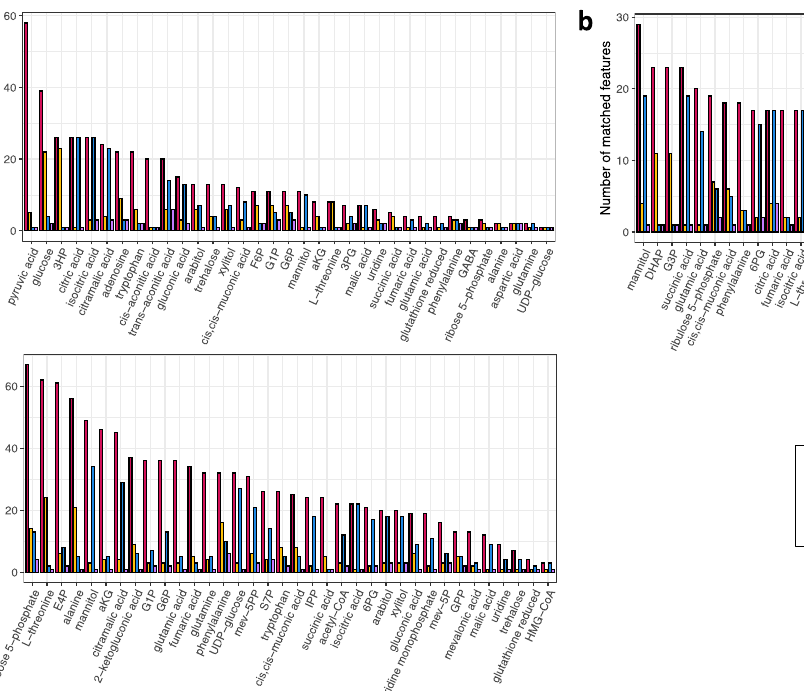
Fig. 4 | Annotation selectivity by different analytical separations in microbial samples. a A.pseudoterreus and A.niger ( n =46). b P.putida ( n =22). c R.toruloides ( n =48). Bars represent the number of possible LC-IM-MS peaks from untargeted feature detection results matched within tolerances. Colors represent the type of match: red=Mass, yellow=Mass-RT, blue=Mass-CCS, and purple=Mass-RT-CCS. In all three microbial datasets, using accurate mass alone resulted in the highest number of features, notably for the metabolites with smaller masses. Combining